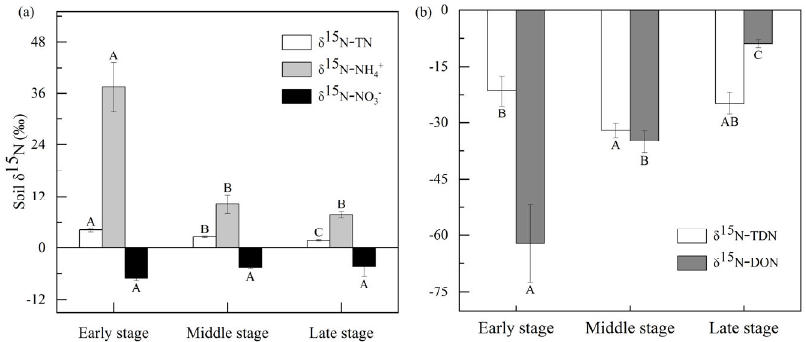
Figure 1. Soil δ 15 N values of DON, NH 4+ , NO 3 − ( a ) and TN, TDN ( b ) in soil at different successional stages. White, gray and black bars represent δ 15 N − TN, δ 15 N − NH 4+ , δ 15 N − NO 3 − δ 15 N − TDN and δ 15 N − DON values of soil, respectively. Each value is the ± 1 SE of the mean and those followed by different letters in the same column are significantly different ( p < 0.05) for dominant species at different successional stages (early (~12 year), middle (~40 year) and late (~120 year) stage). Different capital letters denote significant differences among successional stages, and different species ( p < 0.05), according to Tukey’s test of one-way ANOVA.